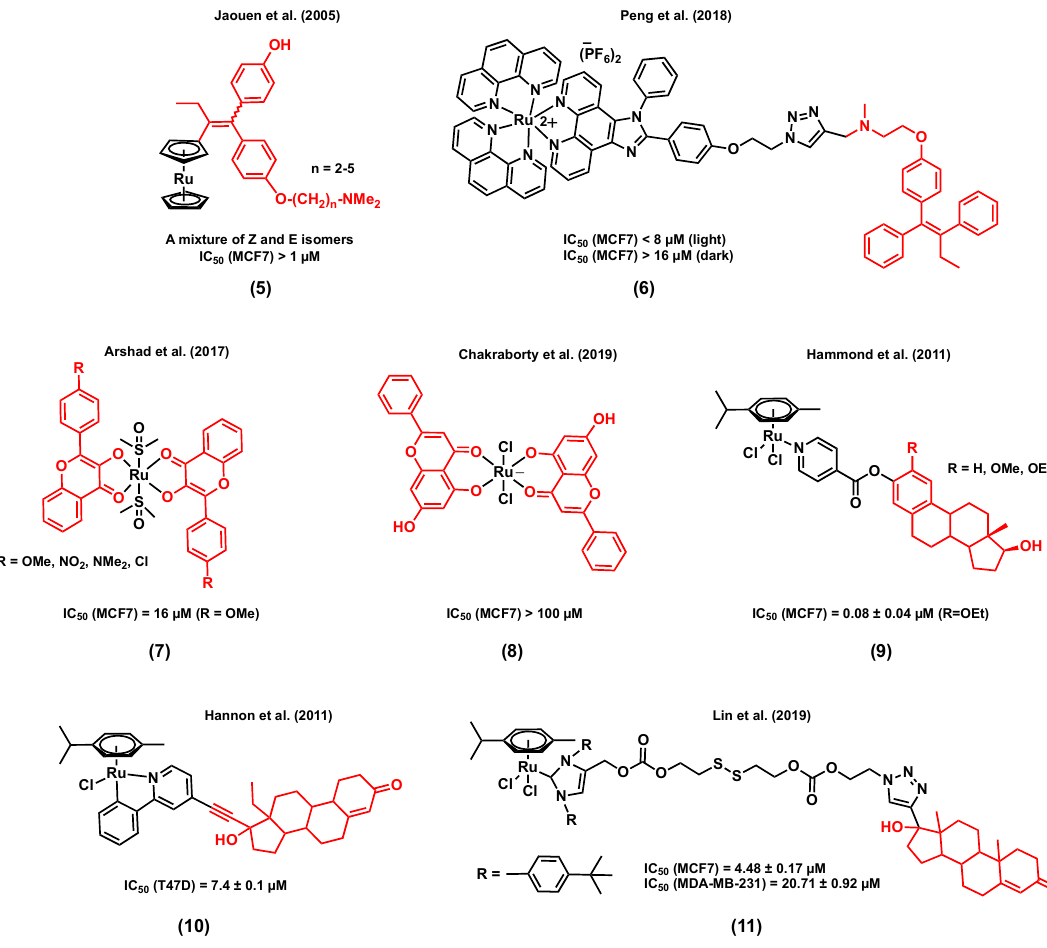
Figure 2. Ruthenium complexes bearing hormone receptor targeting